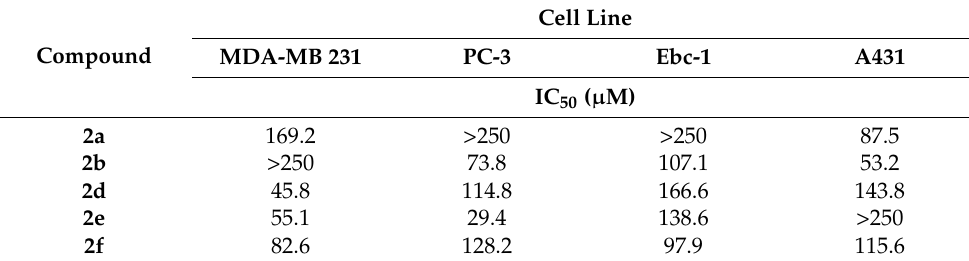
Table 3. IC 50 of the compounds on human tumor cell lines. The 50% inhibitory concentration (IC 50 ) was determined from the dose–response curves fitted on the cytostasis data and is expressed in (Table 2). Compound 2f proved to be the most cytostatic on both A431 (92.8 ± 0.3%) and micromolar